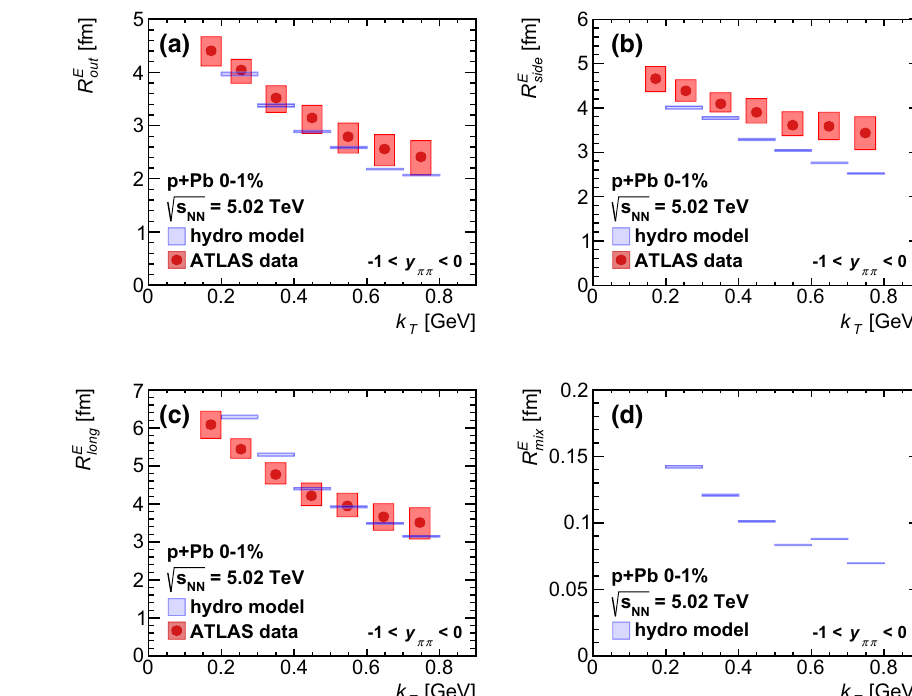
Fig. 2 Interferometry radii in central p+Pb collisions as a function of average pair momentum k T . Results of 3-dimensional hydrodynamic calculations are compared to data from the